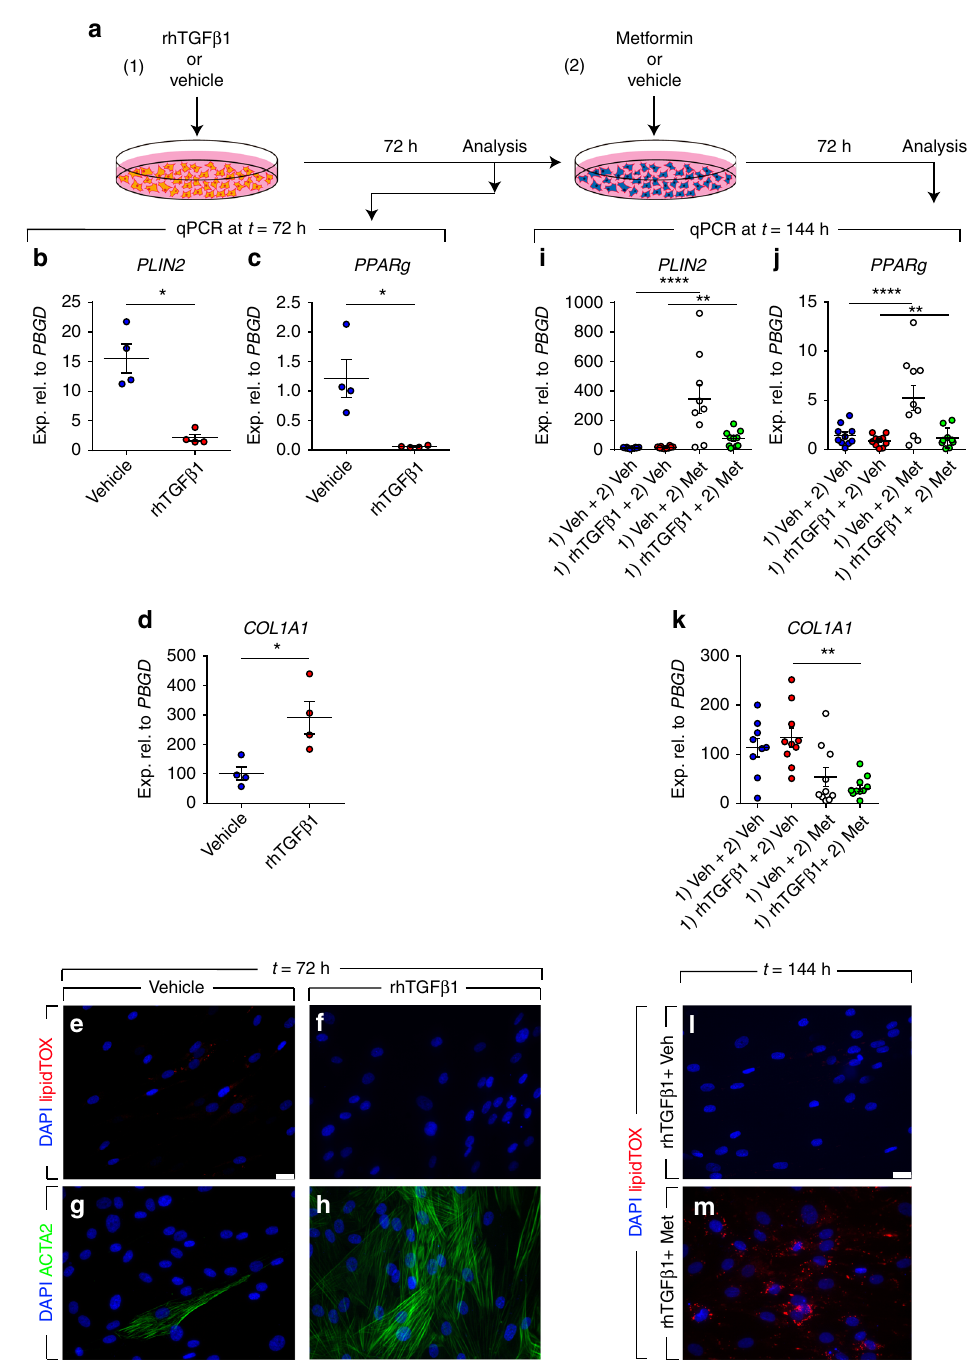
Fig. 2 Metformin attenuates TGF β 1-mediated fi brogenesis in vitro. a Schematic representation of the experimental setup. b – d qPCR analysis for PLIN2, PPARg , and COL1A1 in human lung fi broblasts treated with TGF β 1 or vehicle for 72 h. e – h Staining of TGF β 1- and vehicle-treated cells with LipidTOX (red), anti-ACTA2 antibodies (green), and DAPI (blue). i – k qPCR analysis for PLIN2, PPARg , and COL1A1 in human lung fi broblasts treated with TGF β 1 or vehicle for 72 h, followed by treatment with metformin or vehicle for 72 h. l , m Staining of TGF β 1- and vehicle-treated cells with LipidTOX (red) and DAPI (blue) at the end of treatment ( t = 144 h). Scale bars: (e – h) and (l, m) 25 µ m. Each data point within a given group corresponds to one patient and error bars indicate s.e.m. b – d n = 4 per group. i – k n = 9 – 10 per group. Mann – Whitney test was used in ( b – d ), one-way ANOVA was used in ( i , j ) and Kruskal – Wallis test was used in ( k ). * P < 0.05, ** P < 0.01, **** P < 0.0001. Met: metformin, Veh: